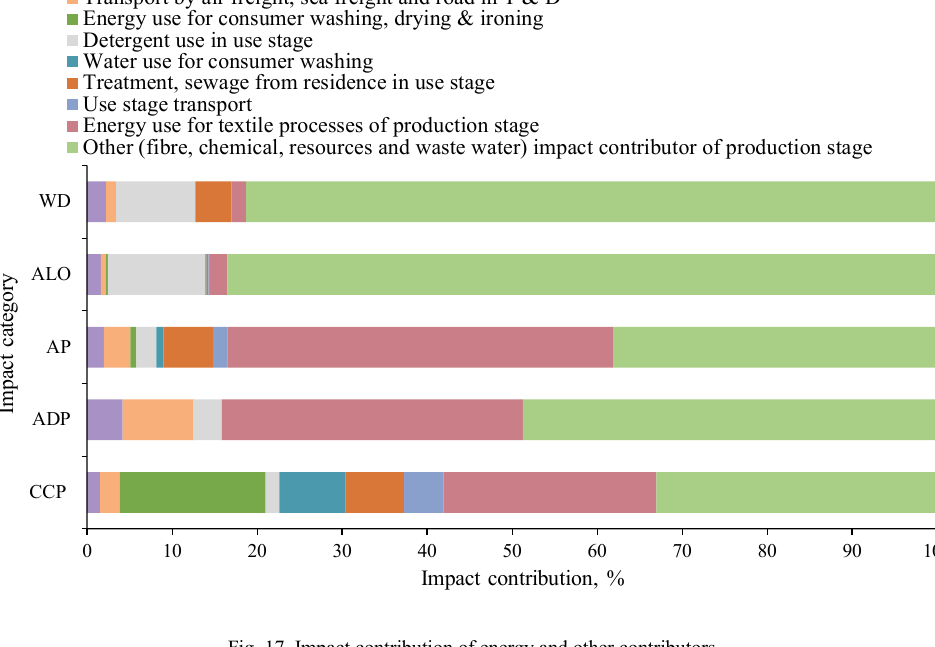
Fig. 17. Impact contribution of energy and other